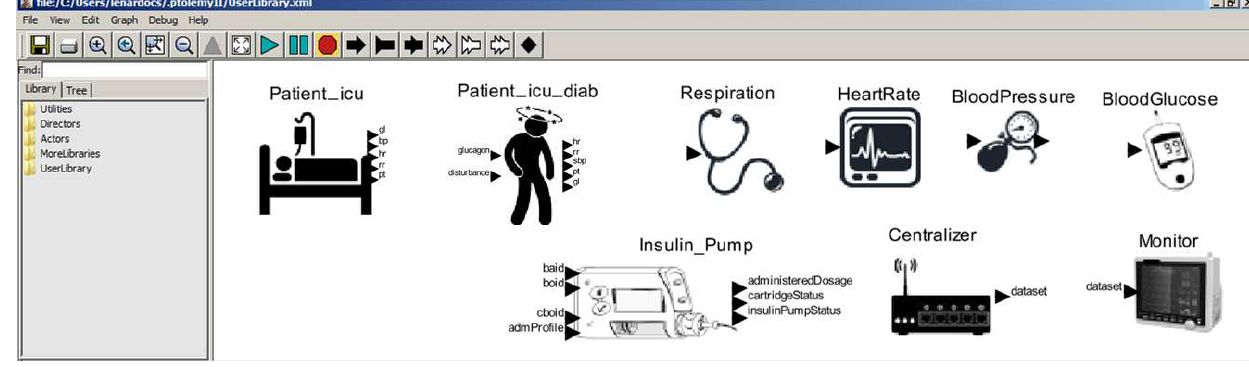
Figure 11. Model Library in Ptolemy